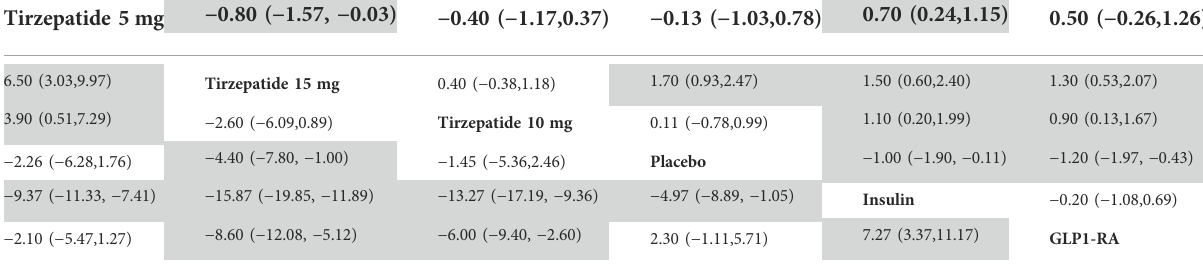
TABLE 1 Results of the network meta-analysis of the HbA1c (upper right quarter) and the body weight (lower left quarter). Tirzepatide 5